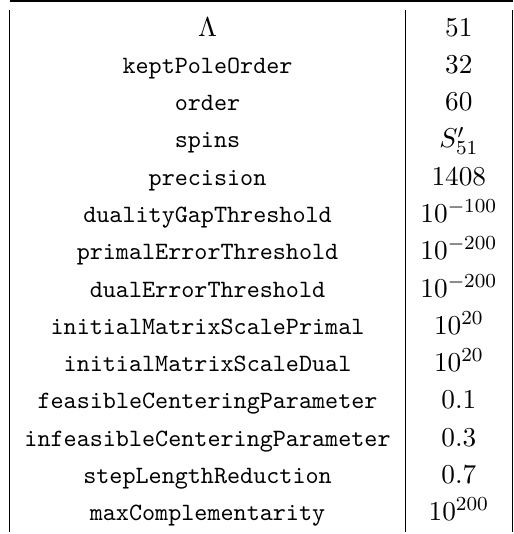
Table 2 . Parameters used for the computations of the conformal bootstrap islands. The sets S Λ are defined in (A.1).